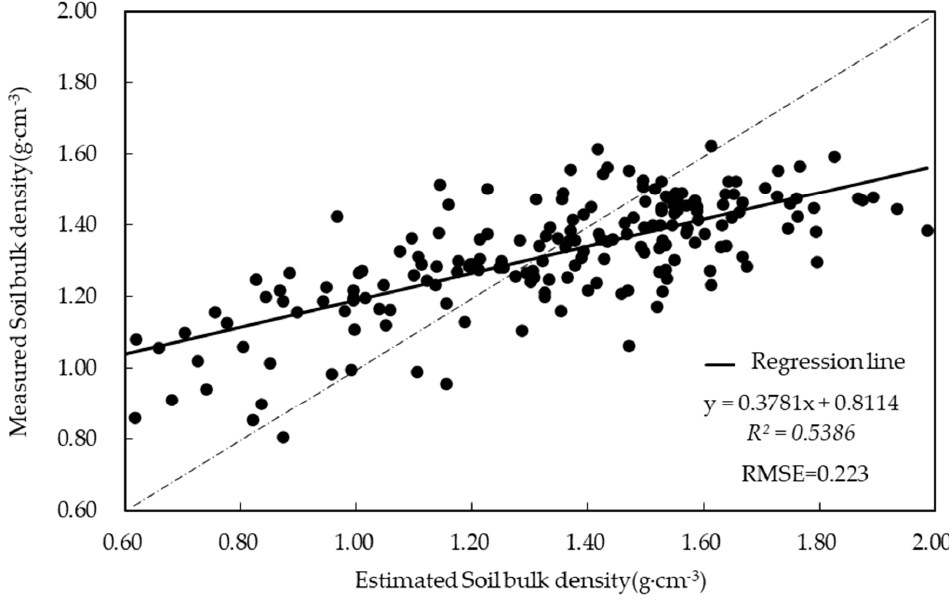
Figure 4. Validation of surface soil (0–50cm) soil bulk density estimation of northern grasslands.